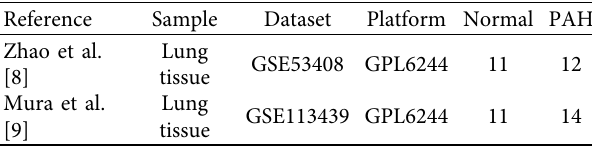
Abbreviations: PAH, pulmonary arterial